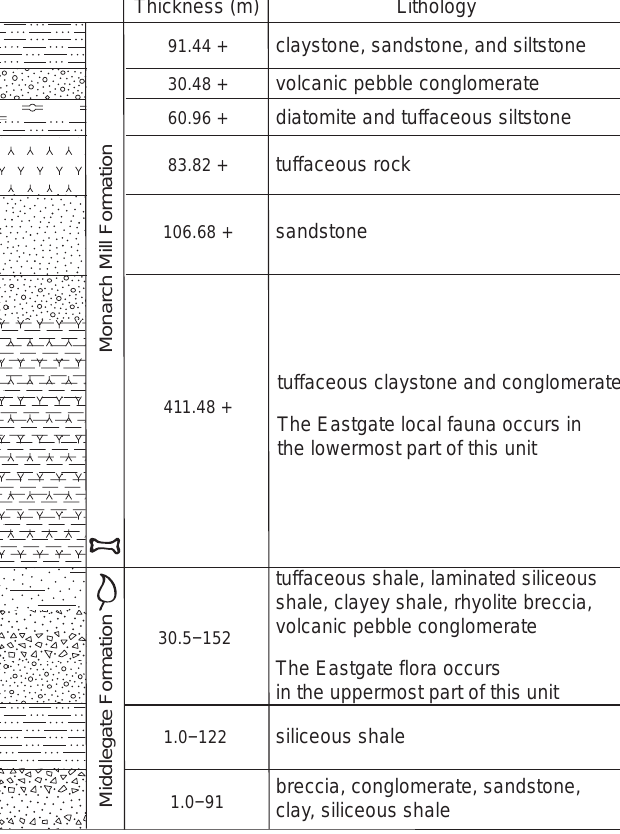
Fig. 2. Basic stratigraphic column of the Monarch Mill and Middlegate for- mations showing the dominant lithologies (modified from Axelrod 1956). The general stratigraphic positions of the Eastgate local fauna and flora are indicated with the appropriate symbols. The specific units dated by Stewart et al (1999) and Swisher (1992) are not shown because of the paucity of available